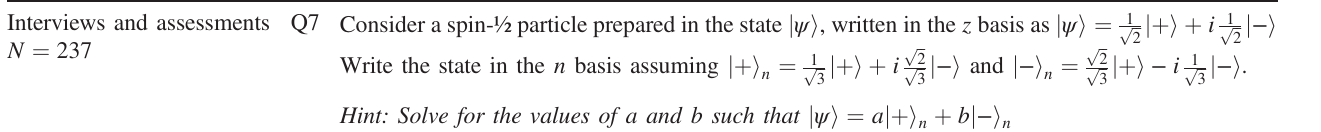
TABLE II. Interview and exam question targeting RQ2 regarding methods students use when changing basis. Versions of this question were administered to students at each of the three institutions on several for-credit quizzes or exams in multiple semesters. Different versions omitted the hint and/or changed the numerical coefficients in the definitions of j(cid:2)i n . Interviews and assessments N ¼